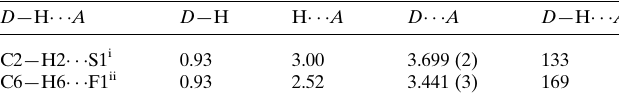
Table 2 Experimental details.